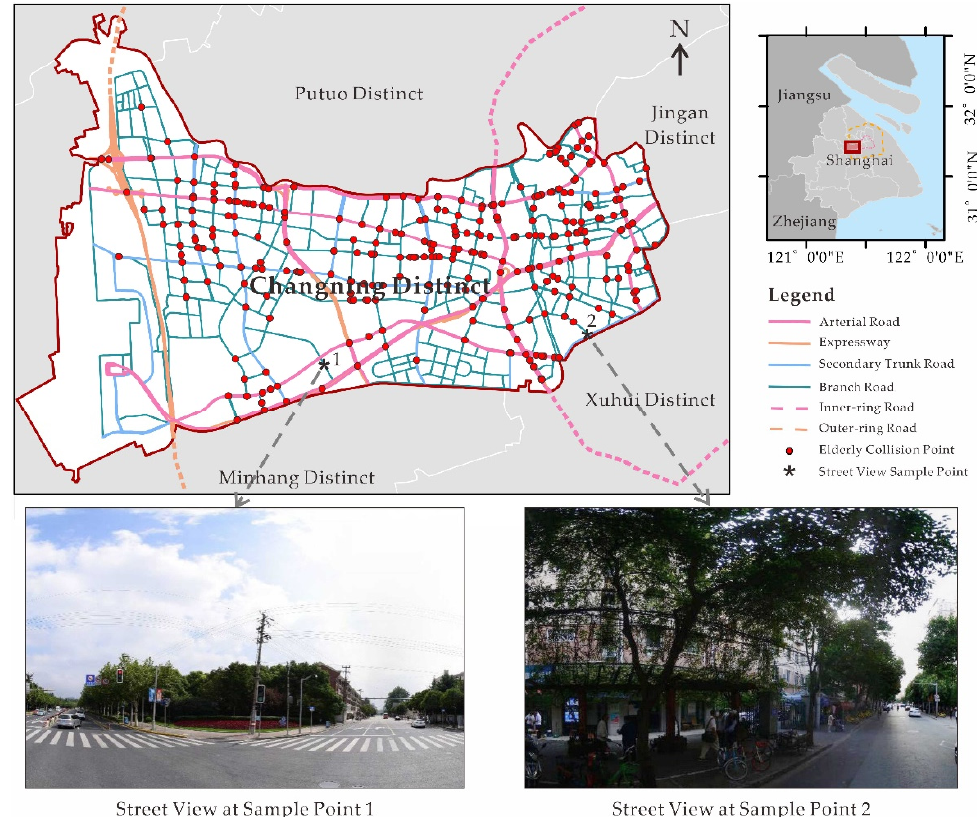
Figure 1. Location of the study area.